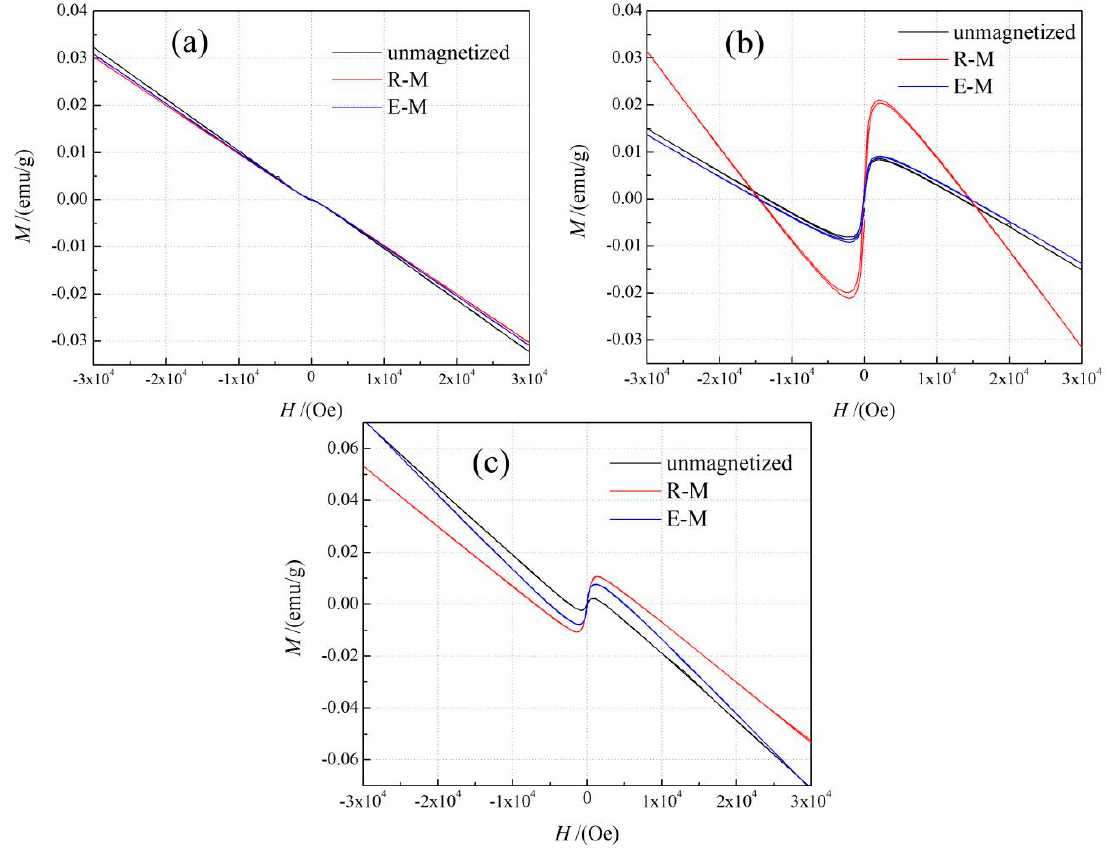
Figure 6. Magnetization curves of ( a ) LDPE; ( b ) 2 wt % nano-BiFeO 3 /LDPE composite and ( c ) 2 wt % micron-BiFeO 3 /LDPE composite after magnetization at room (R-M) and elevated (E-M)